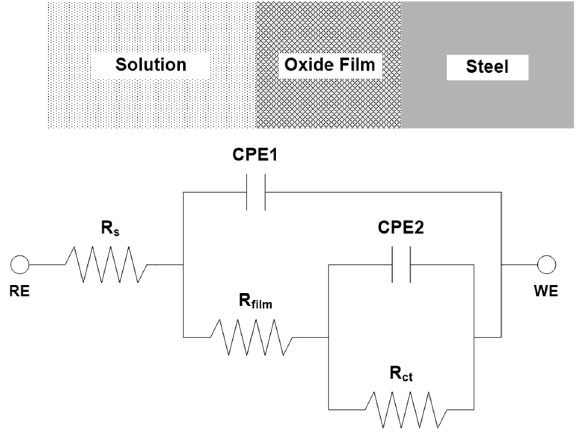
Figure 5. Equivalent circuit for ACS in 3.5 wt.% NaCl solution.